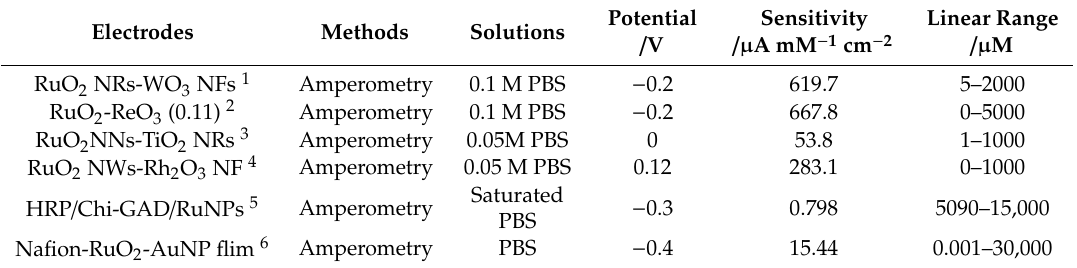
RuO 2 NWs-Rh 2 O 3 NF 4